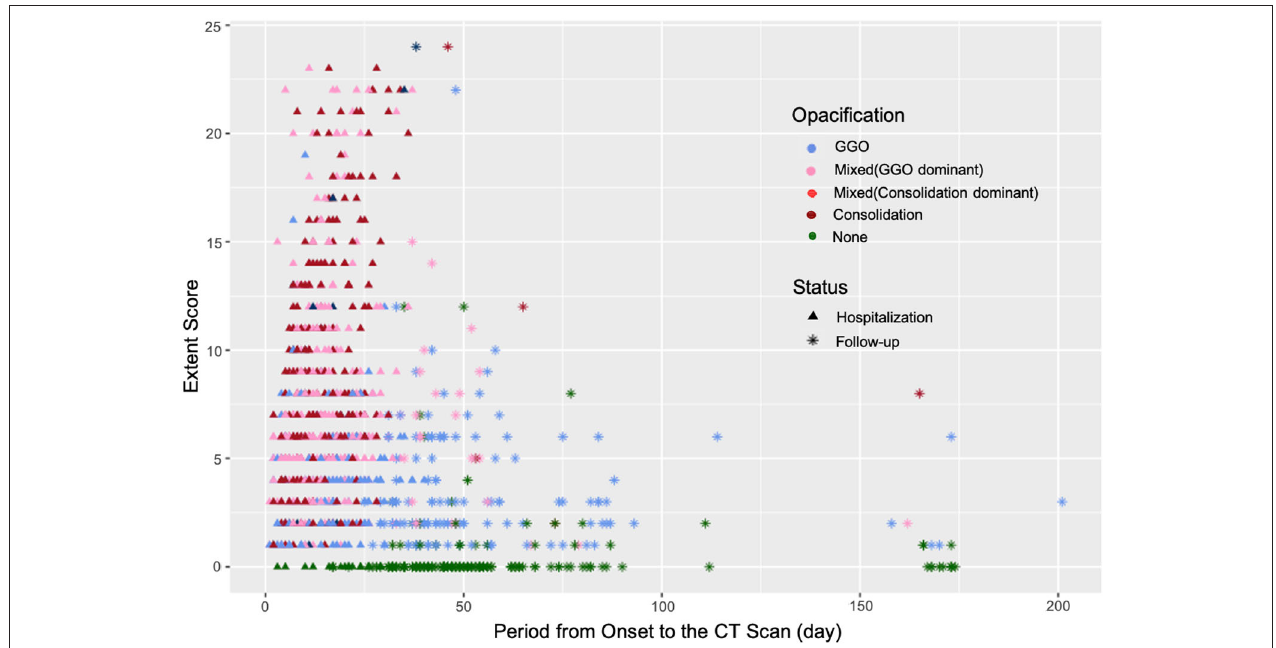
FIGURE 2 | The changes in the Extent Score and opacification in the patients with COVID-19 during hospitalization and follow-ups. The opacities of lesions in the convalescent stage were mainly GGOs with a relatively high Extent Score.